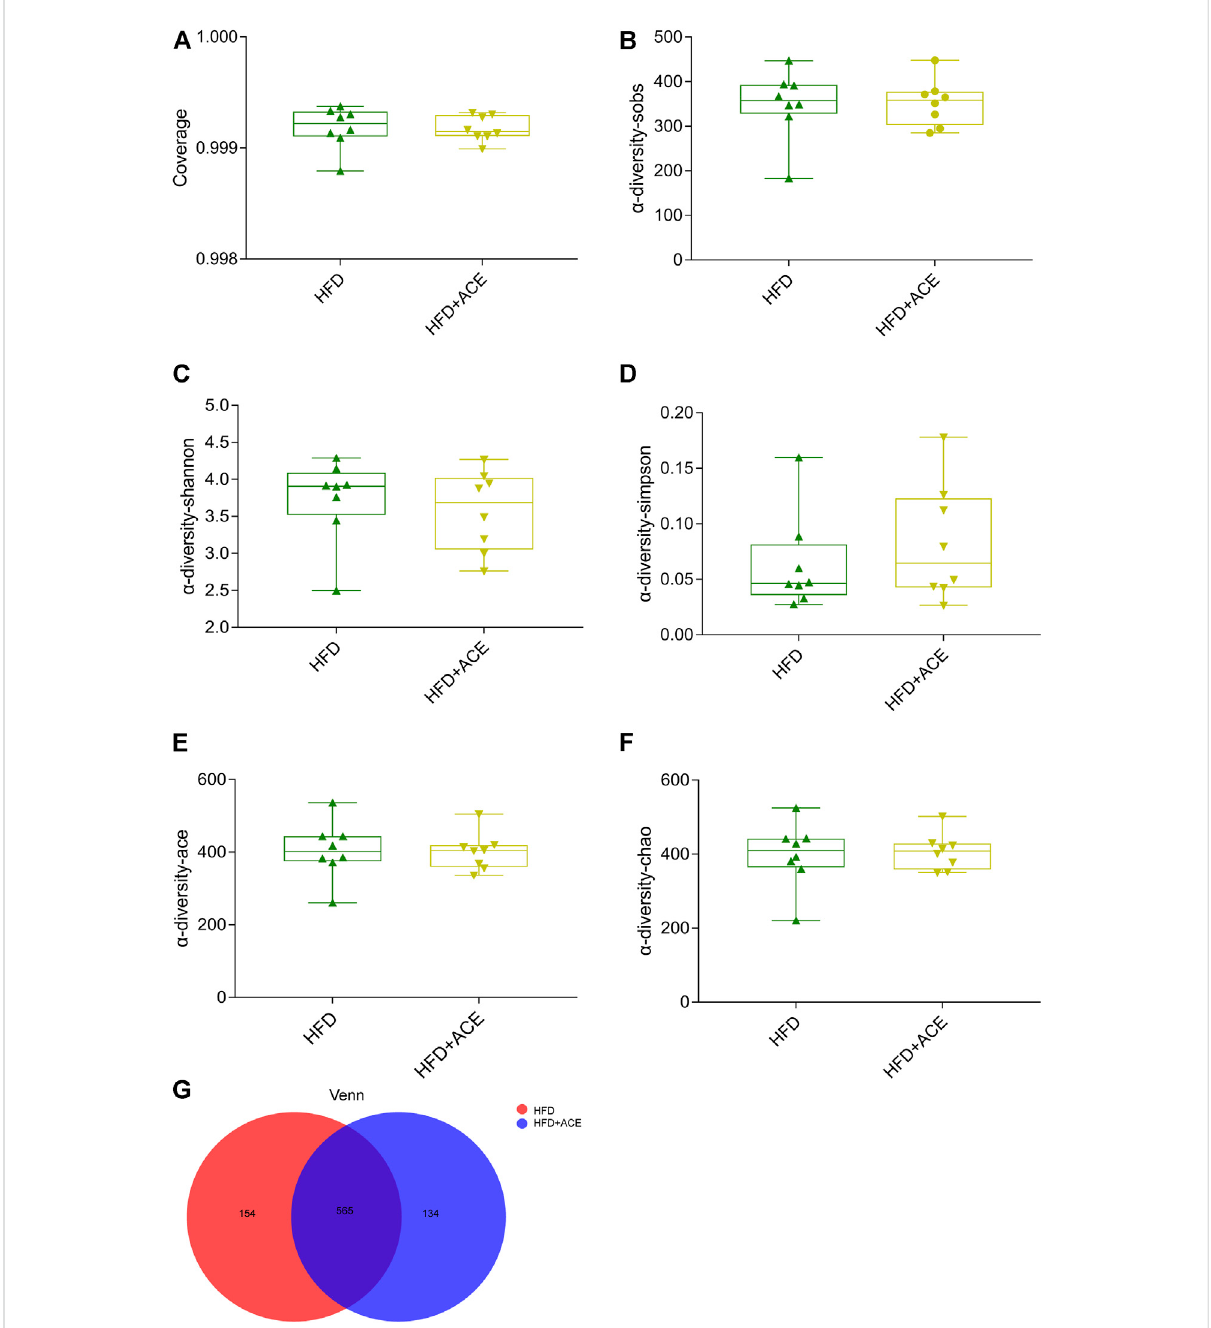
FIGURE 6 ACE did not change the richness and evenness of gut microbiota in HFD-fed mice. (A) The coverage indices of four groups. (B – F) Sobs, Shannon, Simpson, Ace, and Chao were determined to assess the a -diversity of gut microbiota. (G) Venn diagram. Data were shown as means ± S.E.M (n = 8 per group). Statistical analysis was calculated by using an independent student- t